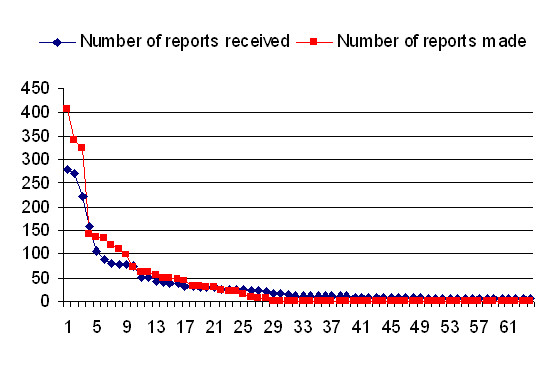
The pattern of reports (y axis) with reporting (detector) in red and reported (transgressor) in blue sorted by country (x axis).